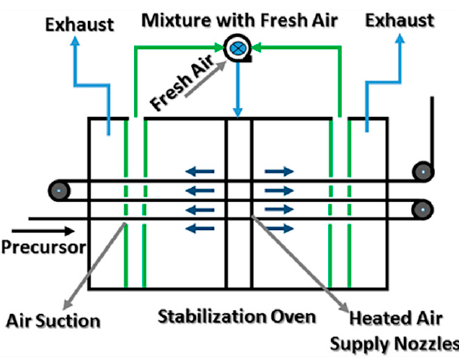
Figure 1. Schematic representation of a stabilization oven with air flow from the center to ends.